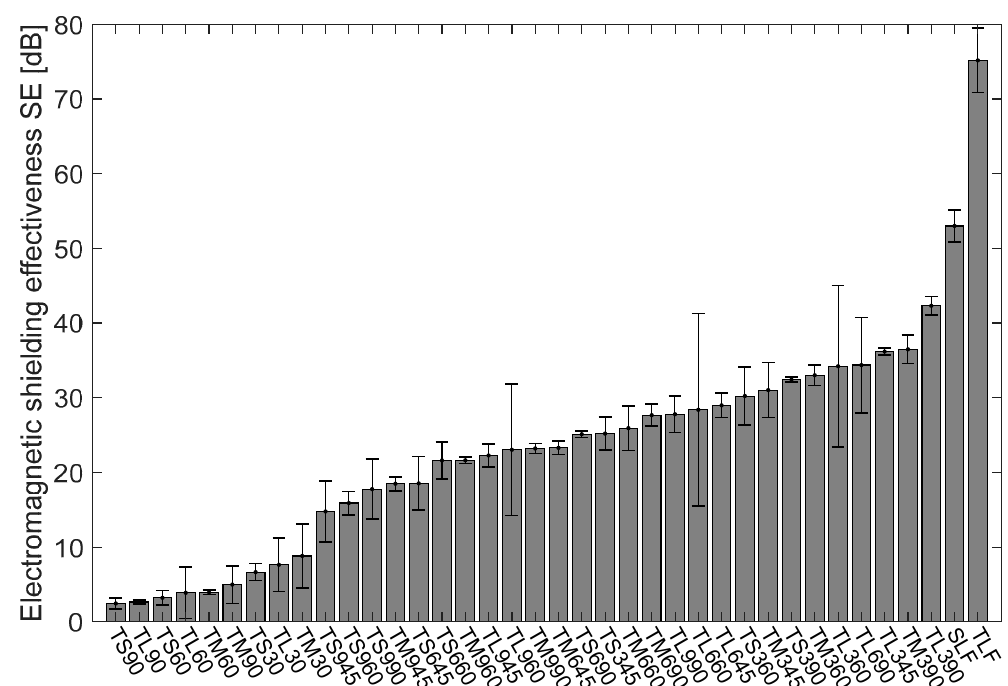
Figure 4. Comparison of the mean value of the electromagnetic shielding effectiveness at 1.5 GHz frequency for Cu/Ni NW strip samples with 95% confidence interval of mean.